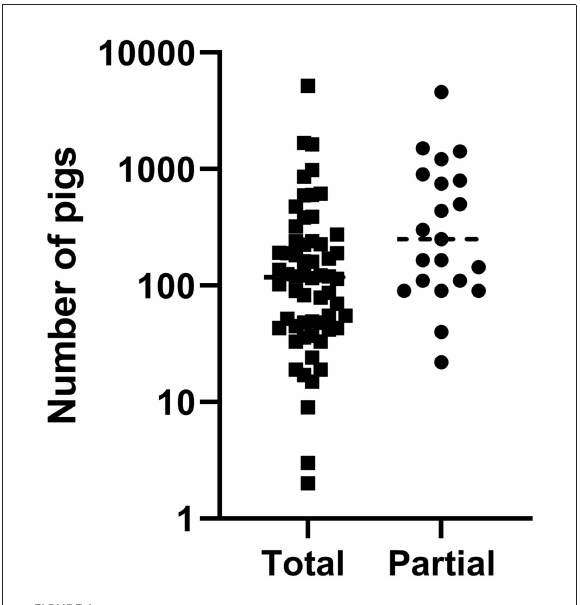
FIGURE1 Farm size distribution separated by culling